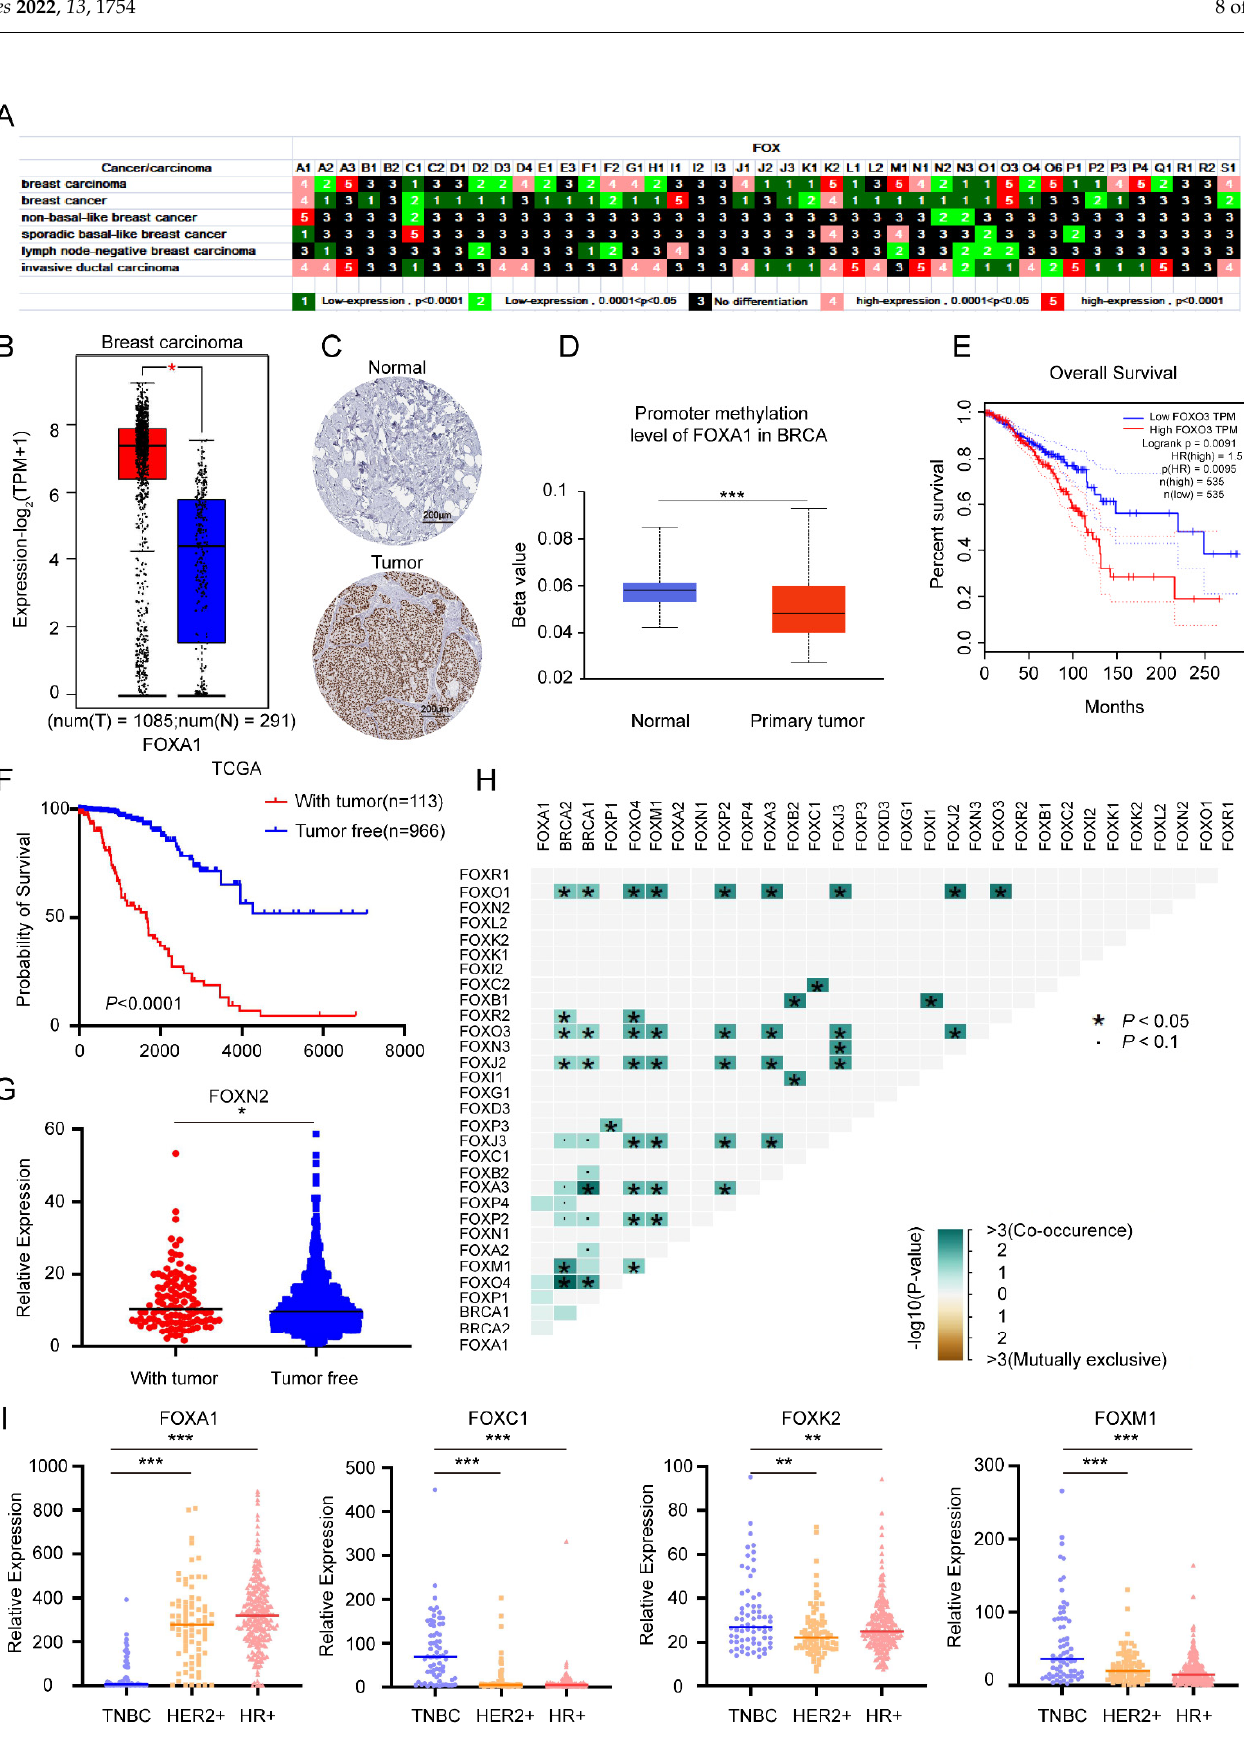
Figure 5. Expression profile of FOX genes in breast cancer ( A ). ( B ) The representative expression